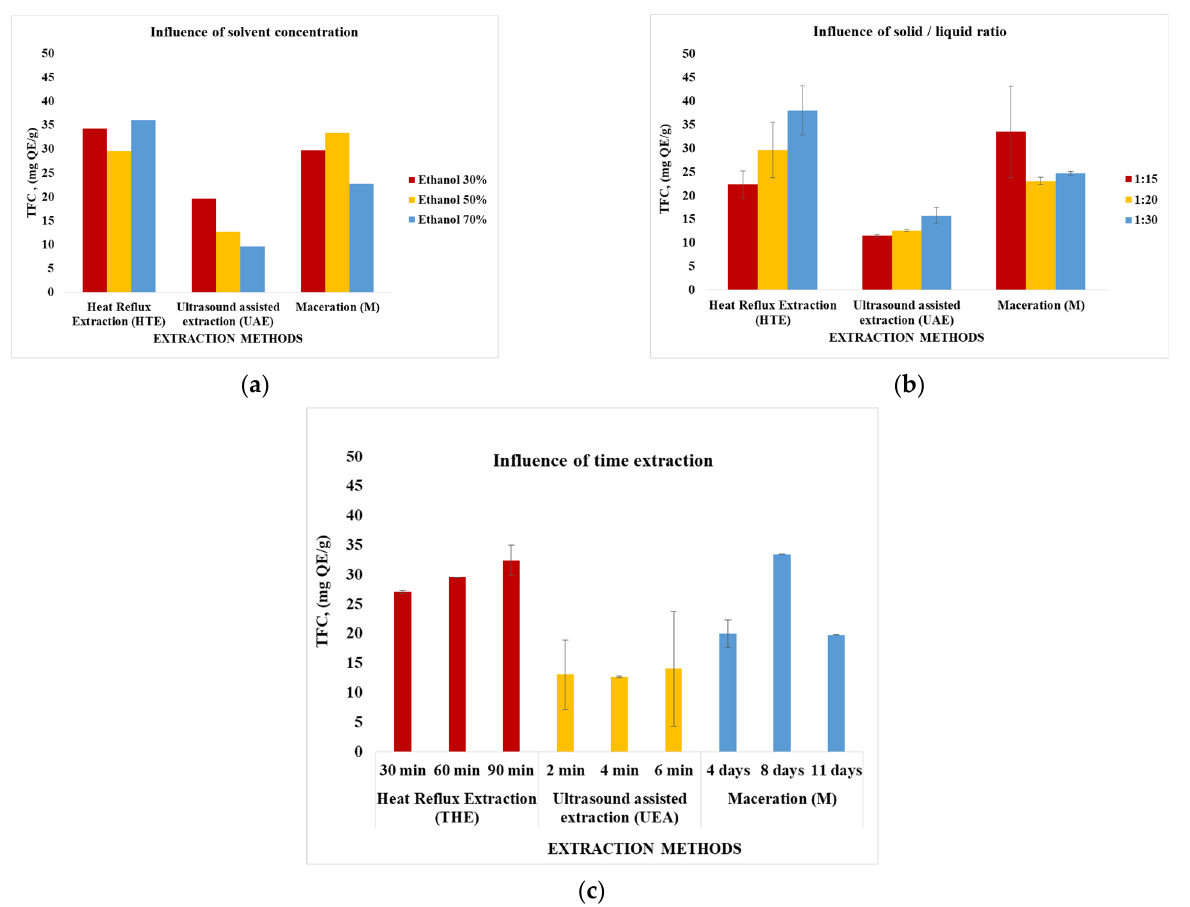
Figure 2. The total flavonoids compounds (TFC) content (mg QE/g) for vegetal extracts obtained by Galium verum dry plant depending on the extraction method used and the physical parameters considered. Conditions: ( a ) HTE—solid/liquid ratio = 1:20 and extraction time-60 min; M—solid/liquid ratio = 1:15 and extraction time -8 days; UEA- solid/liquid ratio = 1:20 and extraction time-4 min; ( b ) THE—solvent concentration = 50% and extraction time—8 days; UAE—solvent concentration = 50% and extraction time—4 min; ( c ) HTE- solvent concentration = 50% and solid/liquid ratio-1:20; M- solvent concentration = 50% and solid/liquid ratio-1:15; UEA—solvent concentration = 50% and solid/liquid ratio-1:20.